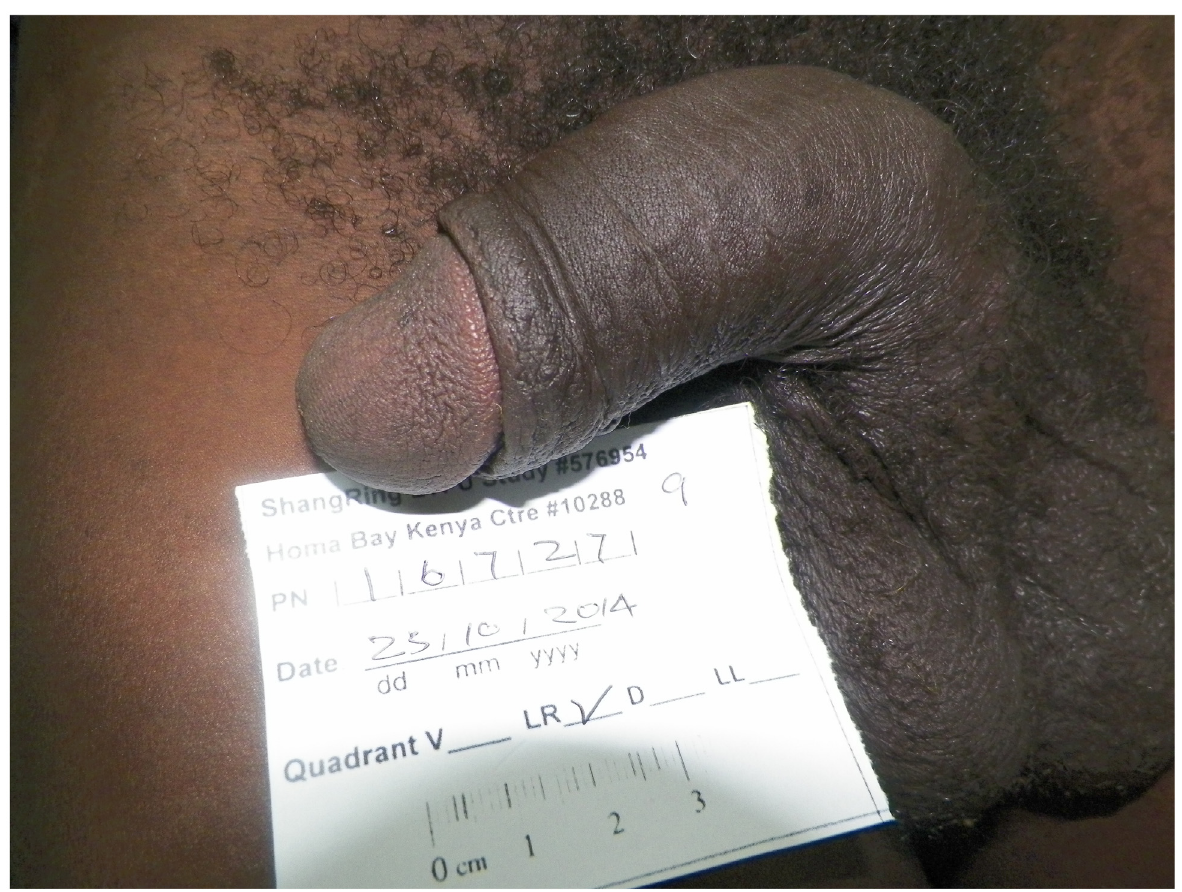
Fig 2. Typical Penile Appearance at Longer-term